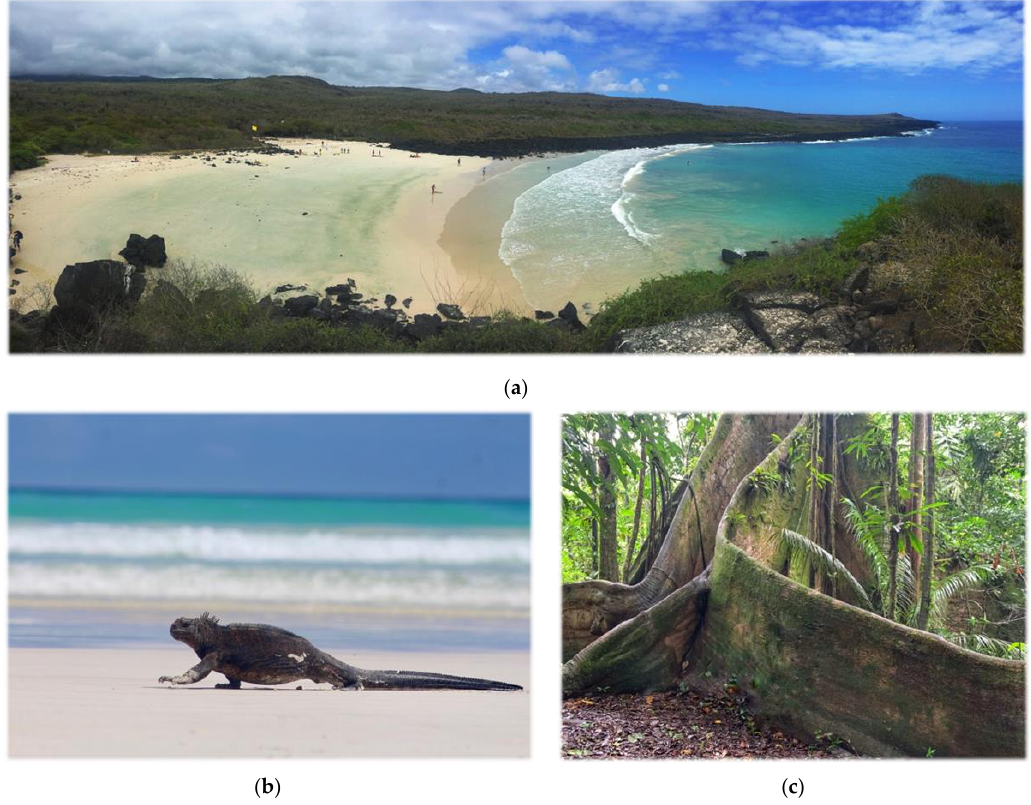
Figure 2. Protected areas in Ecuador: ( a ) Puerto Chino beach, San Cristobal Island, Galapagos National Park; ( b ) Galapagos Marine Iguana ( Amblyrhynchus cristatus ), Galapagos National Park; ( c ) Amazon Ceibo ( Ceiba pentandra ), Yasuní National Park.